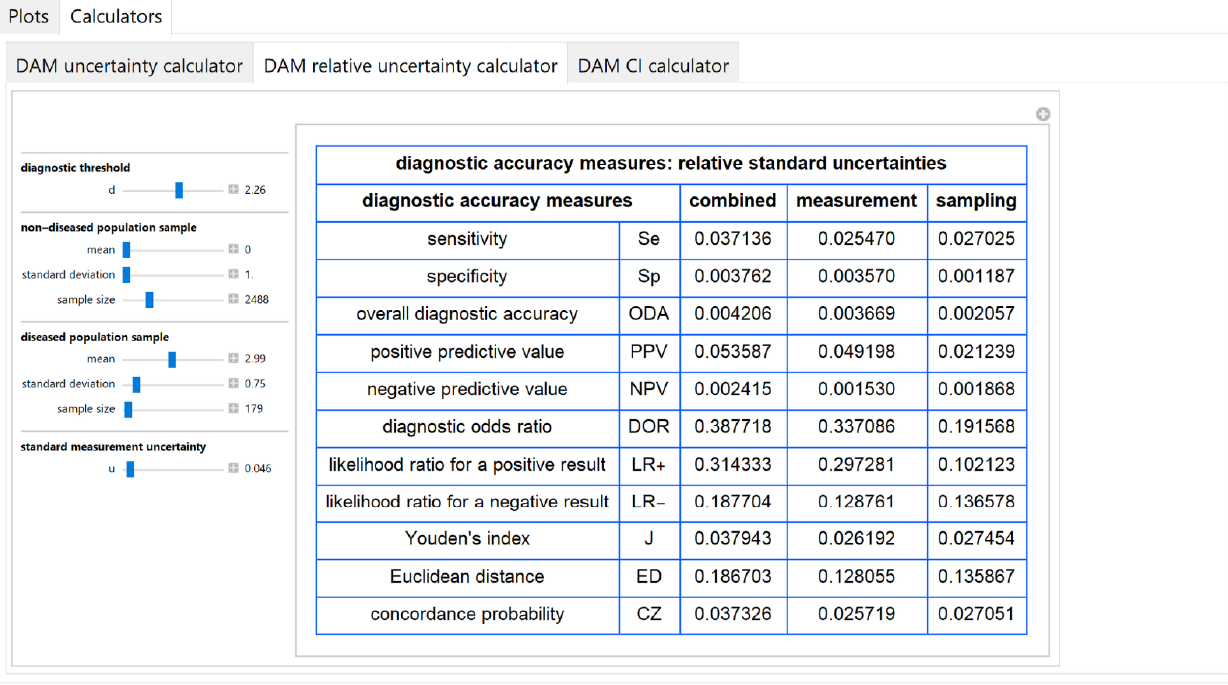
Figure 13. Calculators module, DAM relative uncertainty calculator submodule screenshot. Calculated relative standard Figure 13. DAM uncertainty calculator smodule screenshot. Calculated relative standard combined, measurement and combined, measurement and sampling uncertainty of diagnostic accuracy measures, with the settings shown on the left. sampling uncertainties of diagnostic accuracy measures, with the settings shown on the left. The respective parameter The respective parameter settings are also shown in Table 3. settings are also shown in Table